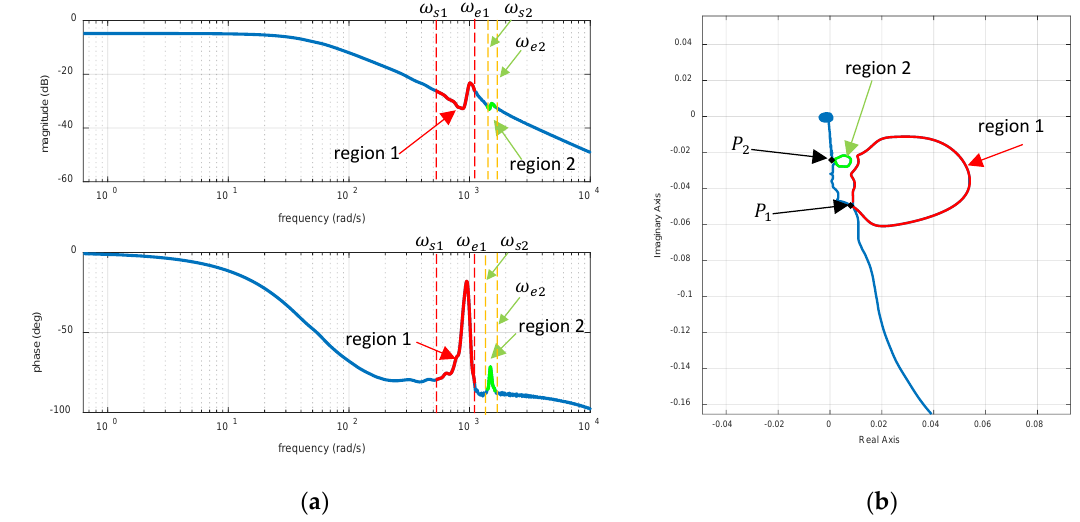
. ( a ) The Bode plot of G m ; ( b ) the Nyquist plot of G m